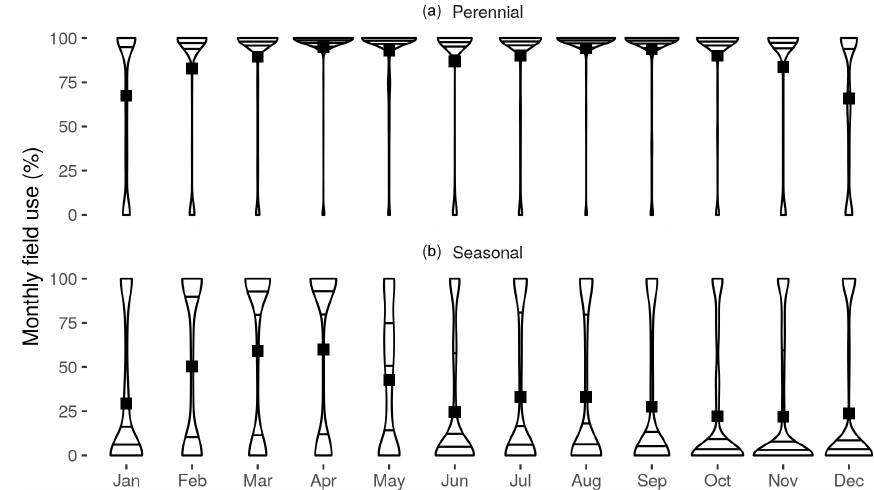
Figure 9. Monthly center-pivot field use for perennial (a) and seasonal (b) fields. The black squares show the average monthly field use (% days irrigated during each month). A larger width at a given level of use indicates a larger number of fields. Horizontal lines show the 25%, 50% (median), and 75%